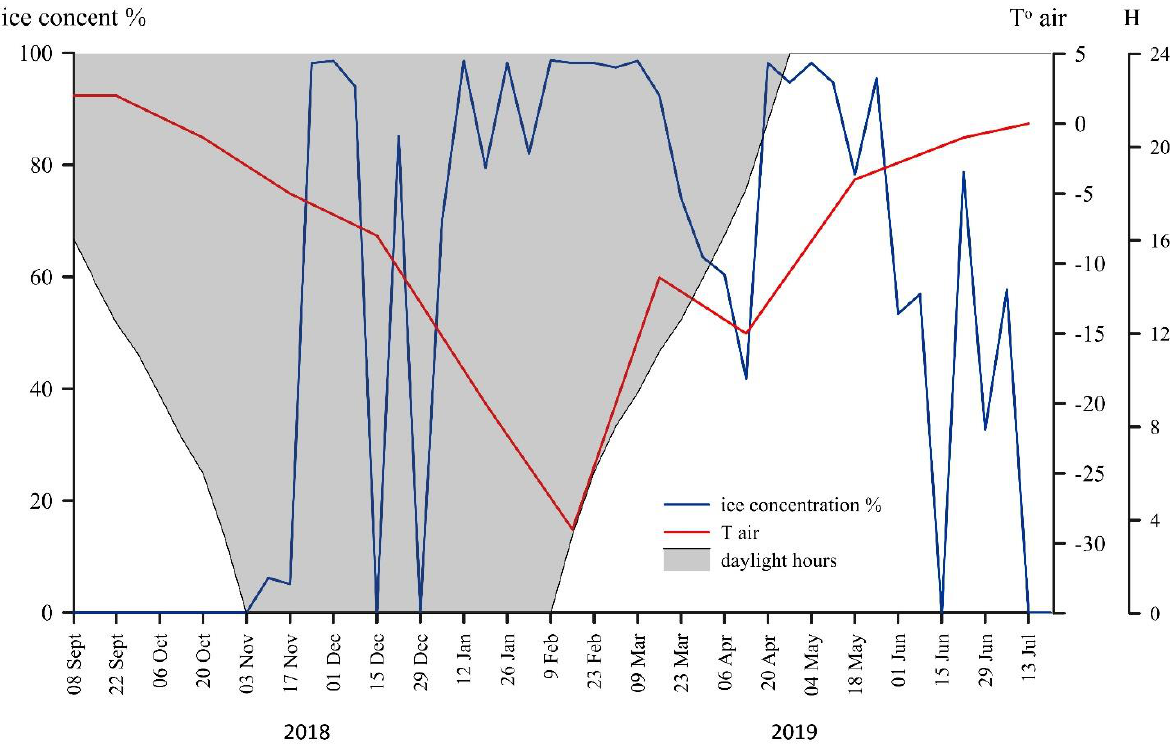
Figure 2. Annual course of air temperature and ice cover (based on data from http://www.aari.ru, accessed on 1 September 2021) in the area of the studied station 5976, the Kara Sea.